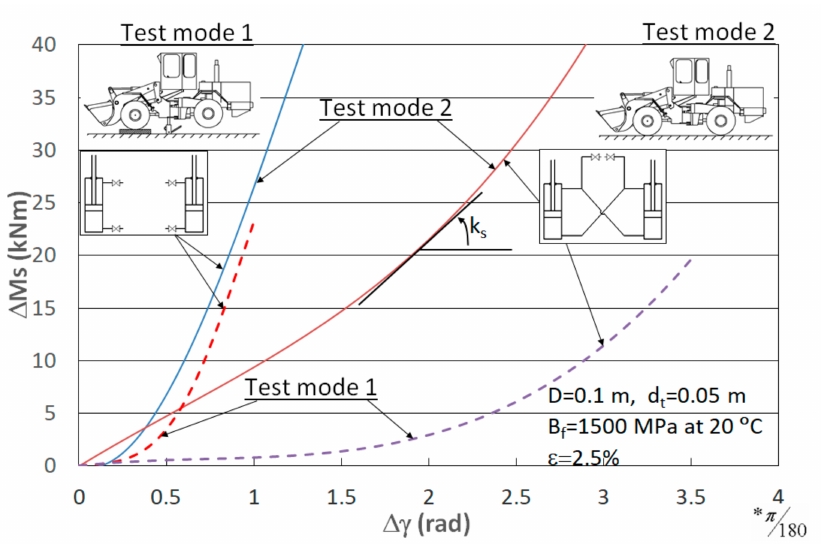
Figure 5. Test results of the effective torsional stiffness k s = ∂ Ms/ ∂ γ of the hydraulic steering mechanism of the test machine (wheel loader Ł220); ∆ M S —steering torque around the articulation joint; ∆ γ —articulation angle.